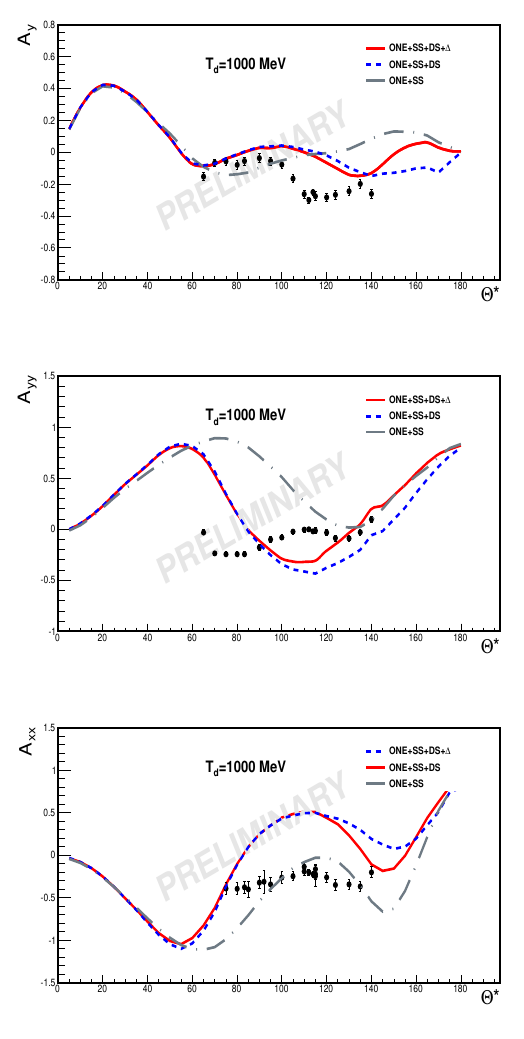
Figure 9. The angular dependence of the vector analyzing power A y at the deuteron kinetic energy T d of 1000 MeV. The full symbols are the preliminary results of the DSS experiment at ITS at the Nuclotron. Lines are the same as in Fig. 6